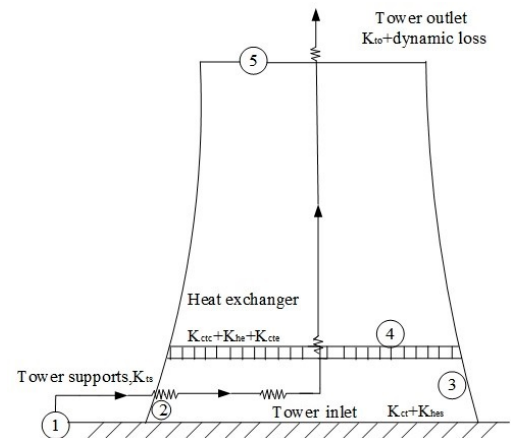
Figure 6. The coefficients of losses of air in NDDCT. Figure 6. The coe ffi cients of losses of air in NDDCT.